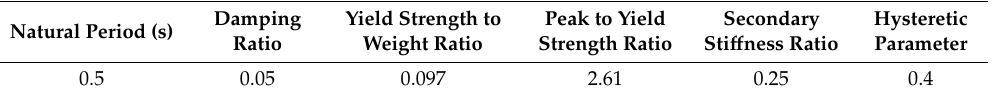
Figure 2. Single degree-of-freedom (SDOF) shear model: ( a ) SDOF shear model; ( b ) tri-linear backbone curve; ( c ) single-parameter hysteretic model. Table 2. Structural parameters of the elasto-plastic SDOF model.